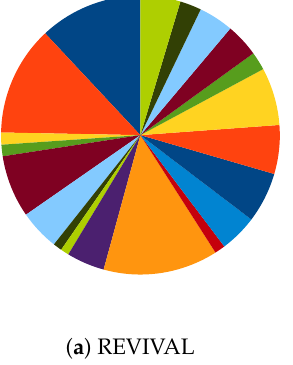
Figure 7. Variance of coordinate values in compression-ratio vectors per dimension: Comparison between REVIVAL and NO_COMMON. For NO_COMMON, more dimensions take very small variances and are not descriptive than